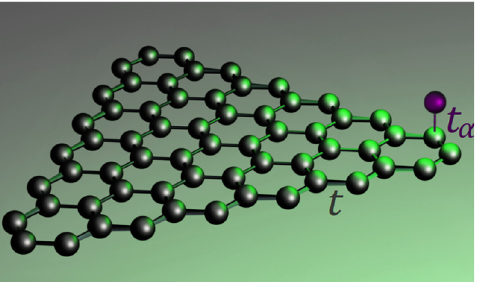
Figure 1: Visualization of the considered hybrid system consisting of a graphene nanoflake and an adatom attached over a particular carbon